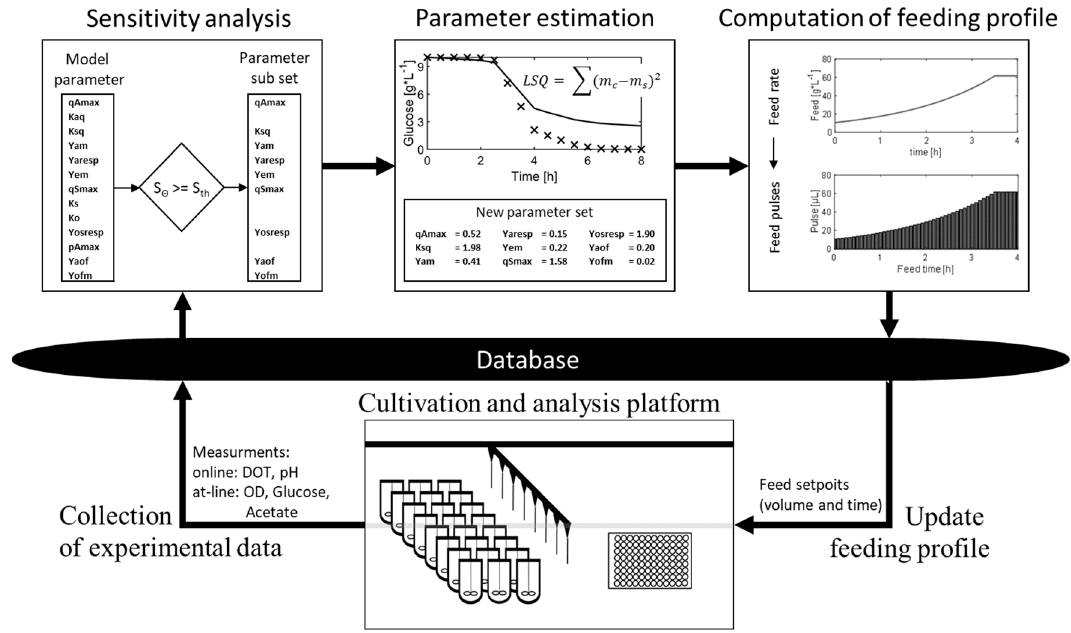
Figure 1. Illustration of the model calibration cycle in the adaptive framework for conditional screening experiments. The cultivation of the clones is performed on the cultivation and analysis platform (consisting of two liquid handling stations and a mini-bioreactor system); samples are collected and autonomously analyzed. The generated online and at-line measurements are sent to the central data storage ( database ). The model calibration cycle starts with the collection of all available data. Based on the measurements, the sensitivity analysis is performed; based on the results, the identifiable parameters are selected, and non-identifiable parameters are not considered/fixed in the subsequent parameter estimation. In the parameter estimation , the identifiable parameter subset is adjusted to fit the model to the measurements. Based on the calibrated model, the feed is calculated during the feed calculation step, according to previously defined criteria. The feed is further converted into corresponding pulses with individual times. These time/pulse setpoints are stored in the database and executed directly by the cultivation and analysis platform.